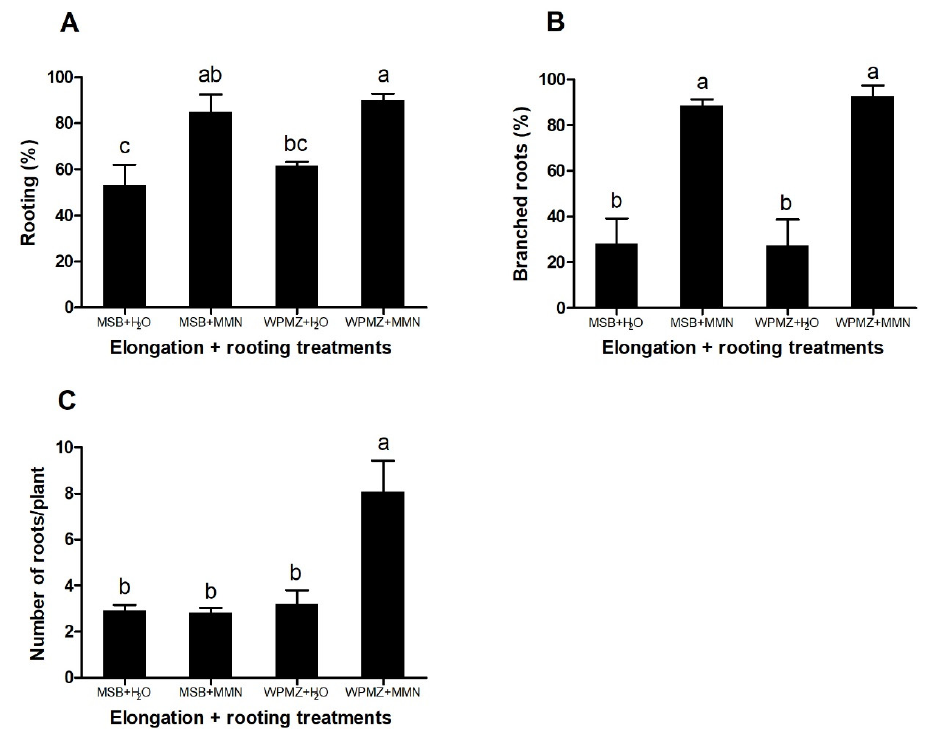
Figure 3. Effects of elongation and rooting media combinations (MSB + H 2 O, MSB + MMN, WPMZ + H 2 O, WPMZ + MMN) in ( A ) rooting percentage, ( B ) percentage of branched roots and ( C ) number of roots/plant. Data represent means of 3 replications of 20 shoots each. Bars indicate standard error. Means with different letters are significantly different (ANOVA and Tukey’s test, p < 0.05).